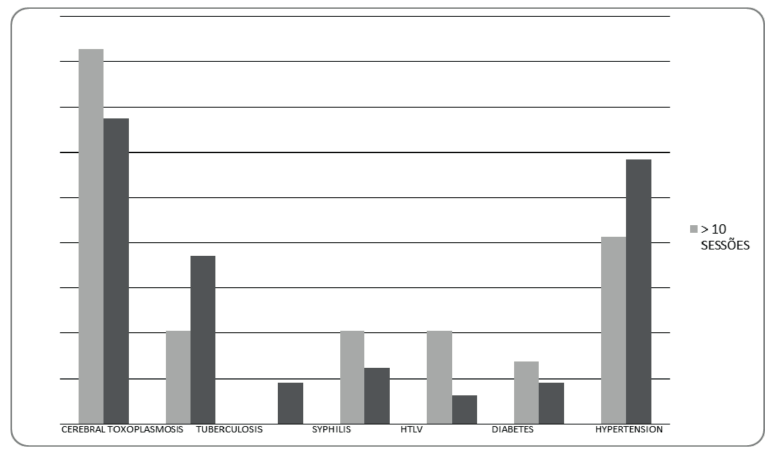
Figure 1 - Distribution of comorbidities according number of physiotherapy ses- sions for infected users with HIV in a Physiotherapy Department in a Specialized Reference Center in Salvador-Bahia from 2009 to